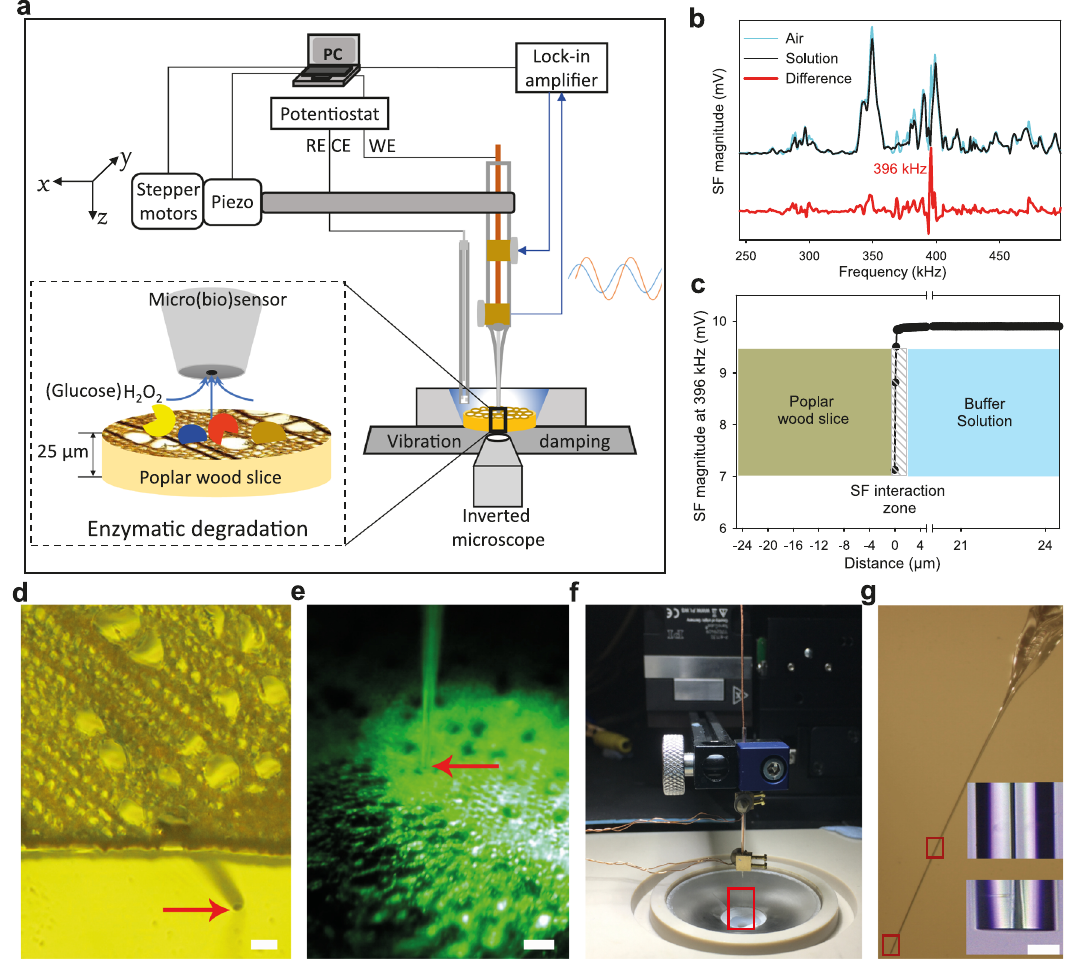
Fig.2|Experimentalset-uptostudytheenzymaticactivityonpoplarwoodcell walls. a Schematic representation of the instruments combined in the SECM platform. b Frequency spectra were acquired using the shear-force mode and two piezo-crystalstooscillate themicrosensorand measureitsattenuationin air(blue) and in solution (black). The red line represents the magnitude difference which indicates 396kHz as the preferable resonance frequency of the used microsensor. The resonance frequencies of all used micro(bio)sensors were in the range of 340 – 416kHz. c The approach curve of a microsensor shows the magnitude chan- ges at the resonance frequency with decreasing distance from the poplar wood